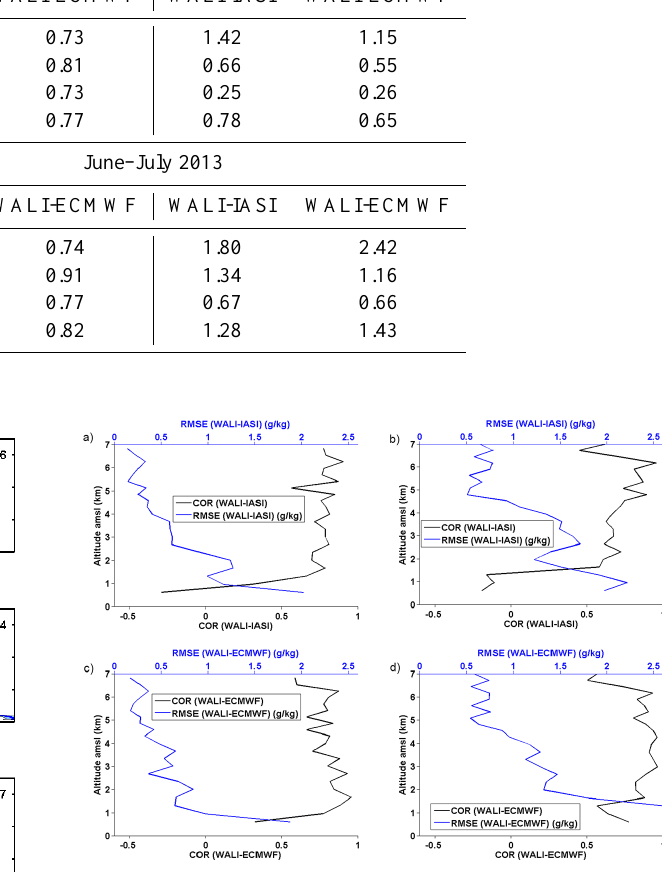
Figure 4. Evolution as a function of altitude of the RMSE in gkg − 1 (blue) and COR (black) between IASI and WALI WVMR retrievals for HyMeX (a) and ChArMEx (b) periods, and between WALI WVMR retrieval and ECMWF analysis for HyMeX (c) and ChArMEx (d)